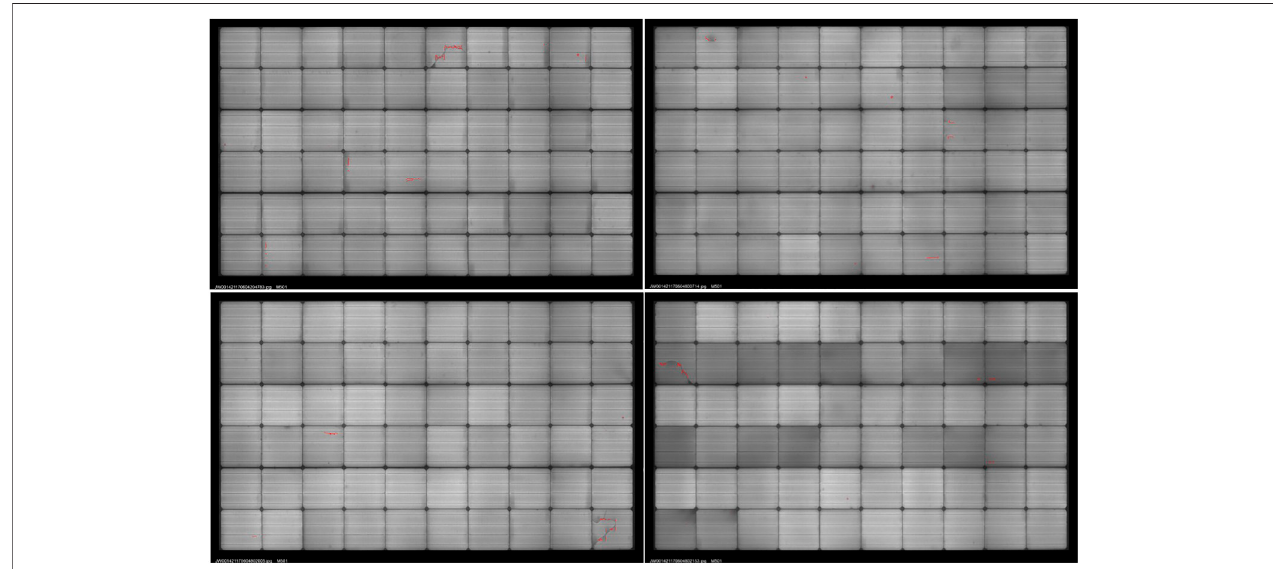
FIGURE 10 | The effect of the algorithm proposed in this article.